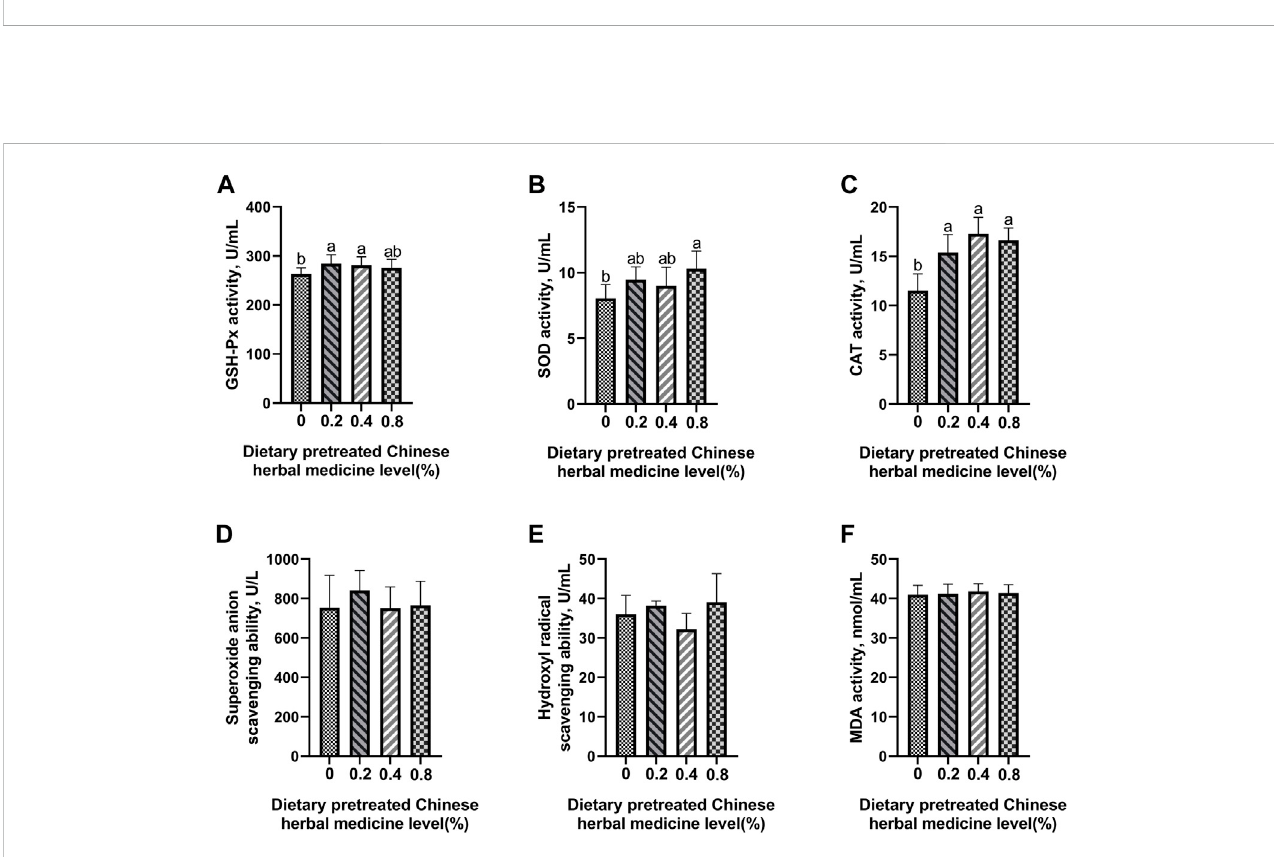
FIGURE 2 Effect of dietary PCHM supplementation on the antioxidant enzyme activity and free radicals in the plasma of late-phase laying hens. (A – C) Glutathione peroxidase (GSH-Px), superoxide dismutase (SOD), and catalase (CAT) activity in the plasma. (D,E) Scavenging free radical abilities in the plasma. (F) Malondialdehyde (MDA)level in the plasma. Values are expressedas means± SEM of six birds per treatment. Means without a common letter differ ( p <